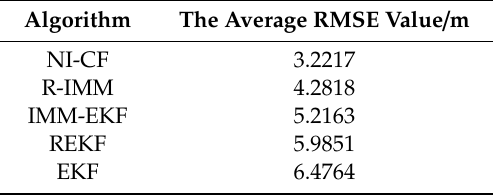
Figure 4. The root mean square error (RMSE) versus the mean value of NLOS error. Table 3. Comparison table of average RMSE value.